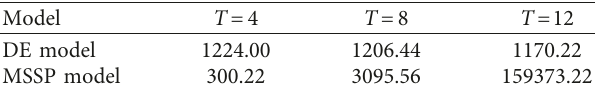
Table 9: Average computational time (ms) of both models.